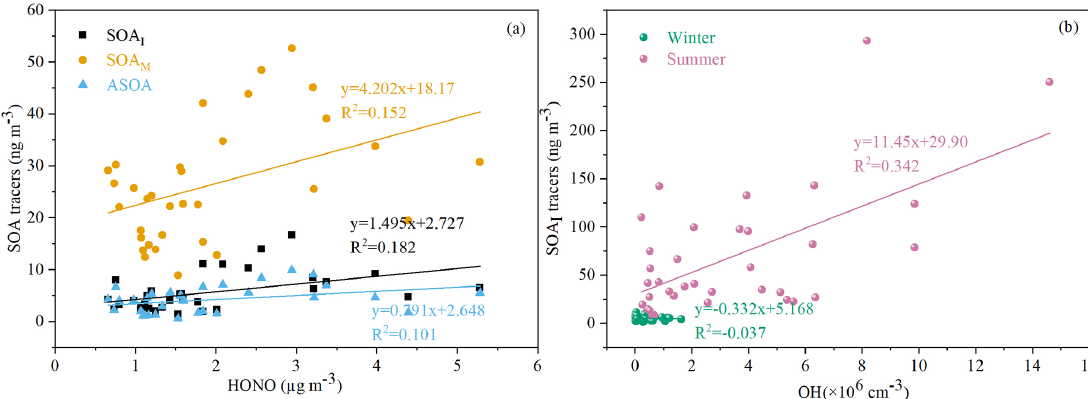
Figure 7. Relationship of SOA tracers and HONO (a) and its estimated OH (b)